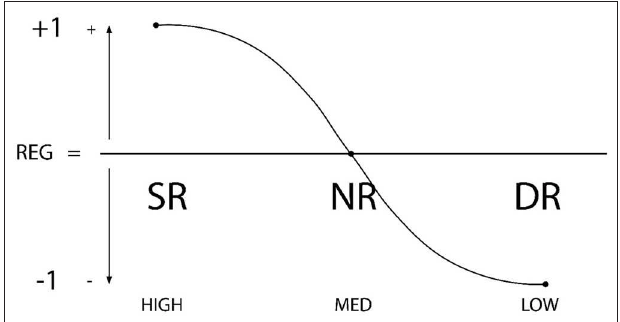
FIGURE 2 | Graphic representation of external regulation types: ER, External Regulation; ENR, External Non-regulation; EDR, External Dys-Regulation. The X axis represents the degree of external regulation (high-medium-low), while the Y axis shows the directionality of the external regulation ( + 1, 0, − 1).